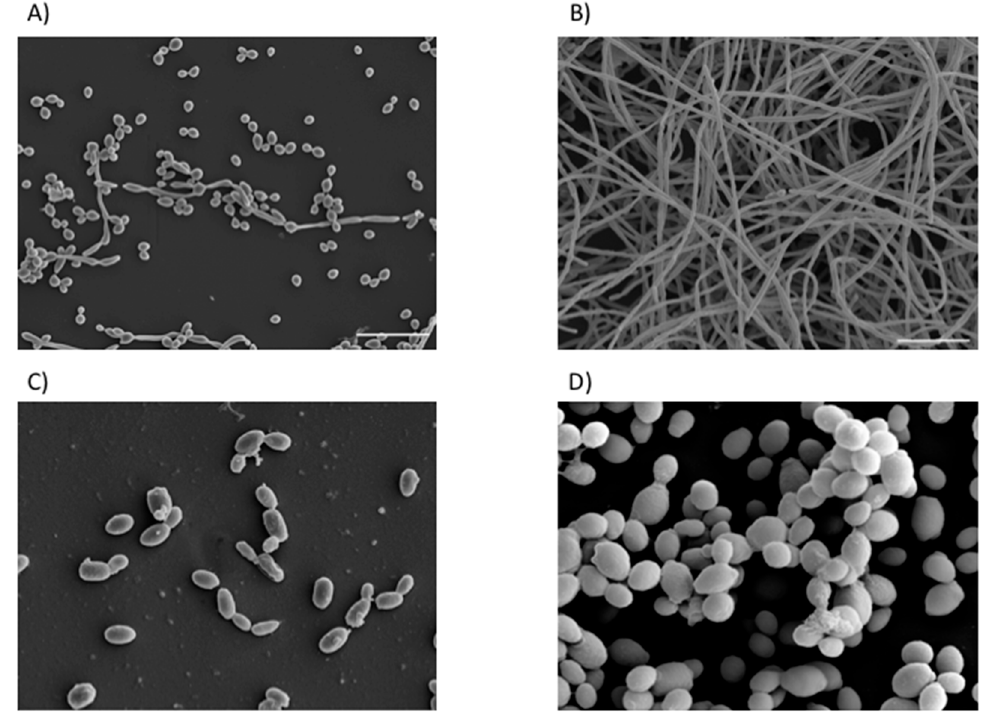
Figure 2. Differential biofilm formation of Candida species. Scanning electron micrograph (SEM) of C. albicans low biofilm formers (LBF) ( A ) existing as mainly yeast cells and pseudo-hyphae, compared to the hyper-filamentous morphology of the high biofilm formers (HBF) ( B ); Micrograph of C. glabrata biofilm sparsely populating the surface ( C ); SEM image of a biofilm formed by an aggregating strain of C. auris ( D ). Scale bars represent 20 µm at ×1000 magnification.